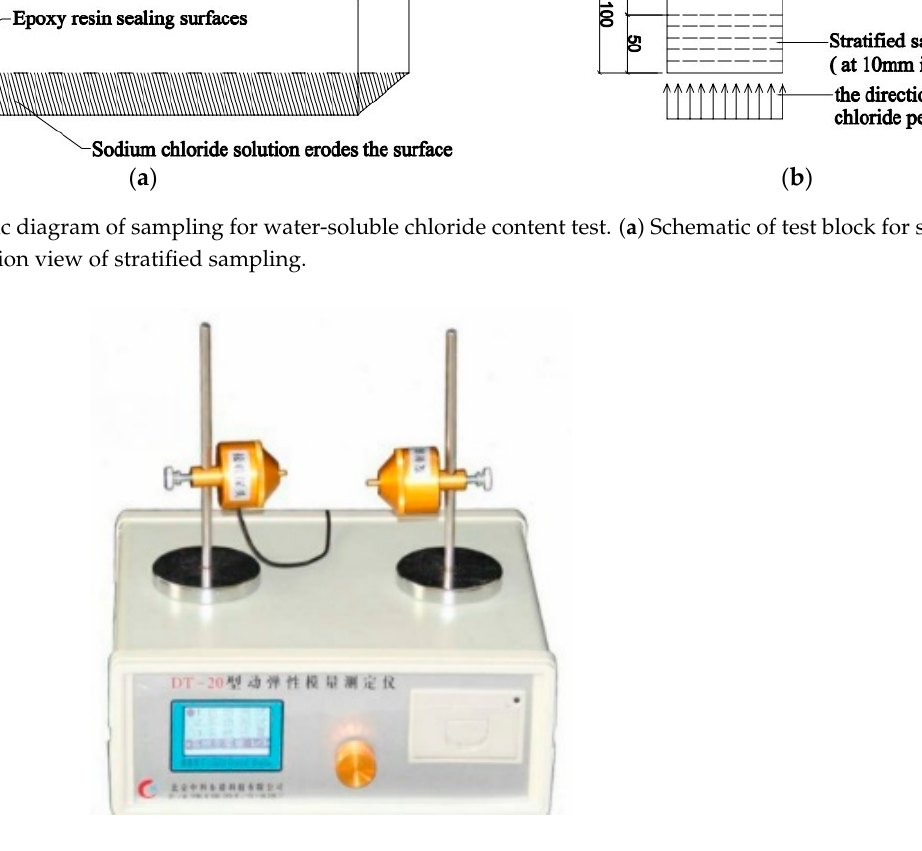
Figure 3. DT-20 Dynamic Elastic Modulus Measurement instrument.